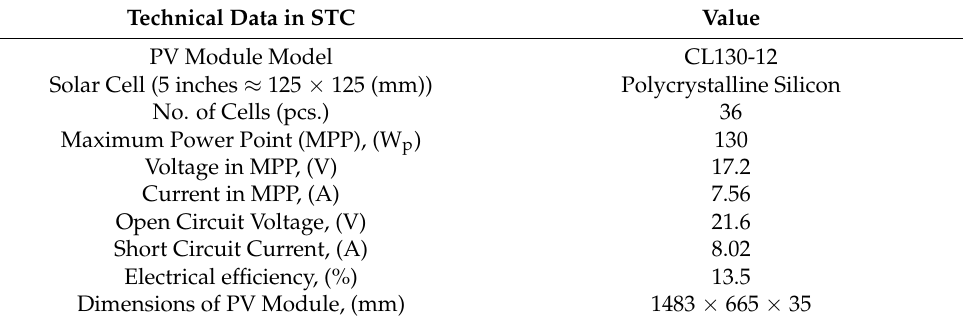
Table 1. Selected technical data of the PV module according to the manufacturers. Technical Data in STC Value PV Module Model CL130-12 Solar Cell (5 inches ≈ 125 × 125 (mm)) Polycrystalline Silicon No. of Cells (pcs.) 36 Maximum Power Point (MPP), (W p ) 130 Voltage in MPP, (V) 17.2 Current in MPP, (A) 7.56 Open Circuit Voltage, (V) 21.6 Short Circuit Current, (A) 8.02 Electrical efficiency, (%) 13.5 Dimensions of PV Module, (mm) 1483 × 665 ×